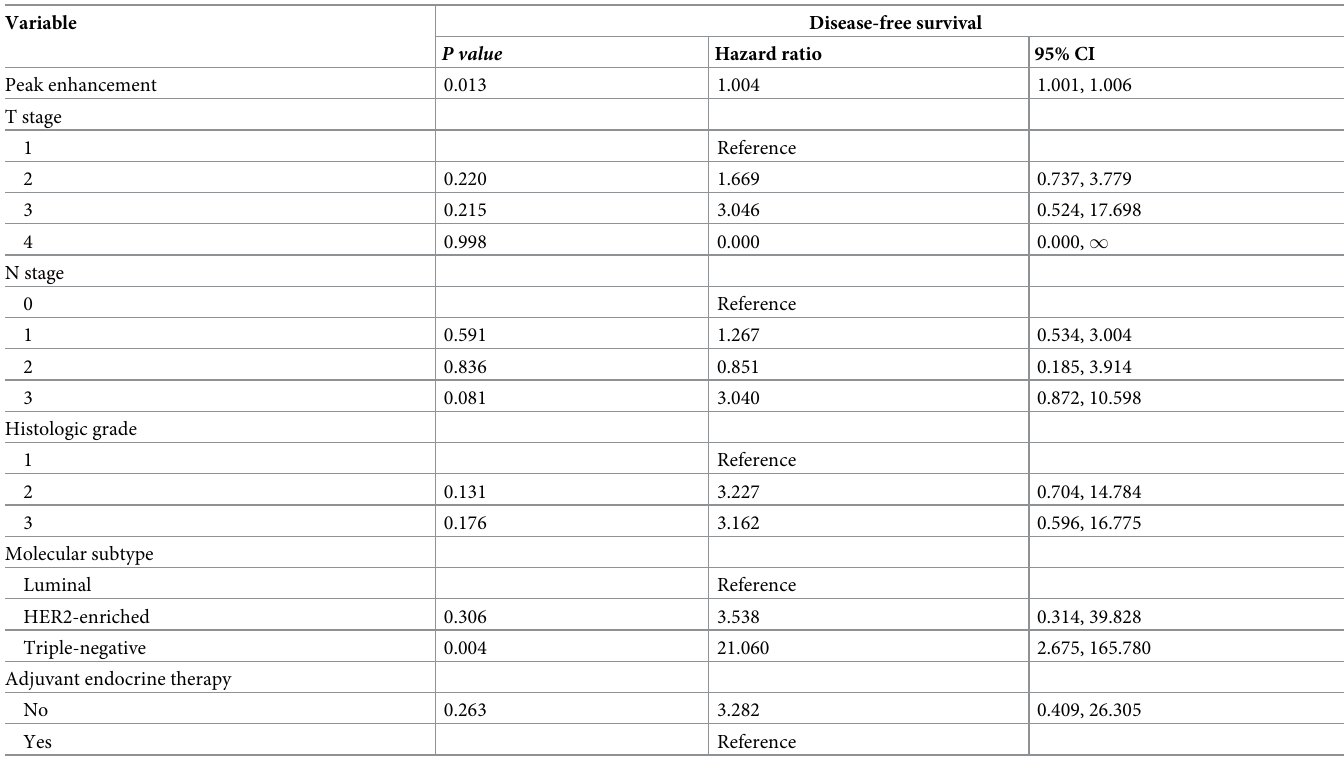
Table 3. Multivariate Cox proportional hazard analysis of clinicopathological variables and MR imaging kinetic parameters with survival